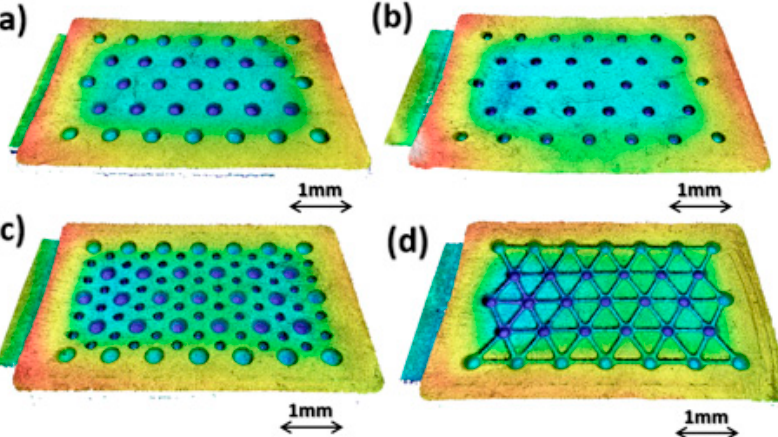
Figure 14. Isometric 3D view of the molded HDPE samples: HEX-300 ( a ); HEX-200 ( b ); HEX-300-150 ( c ); HEX-300+CH ( d ).